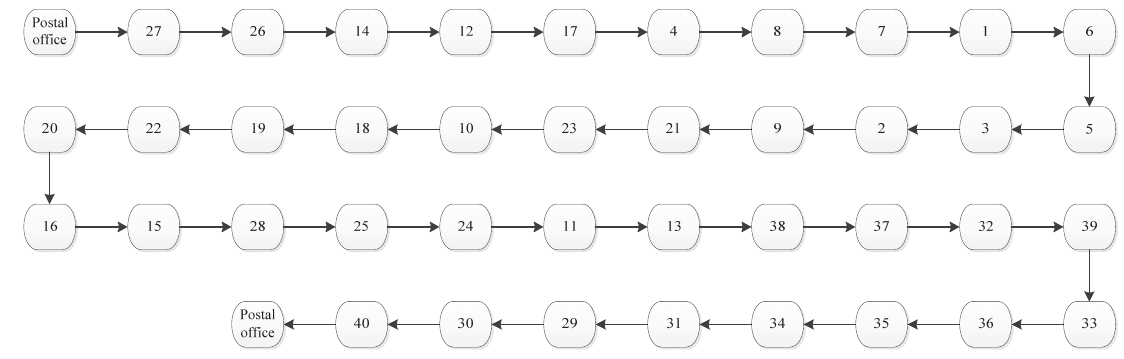
Fig. 8. The optimum route for servicing customers with the departure time at